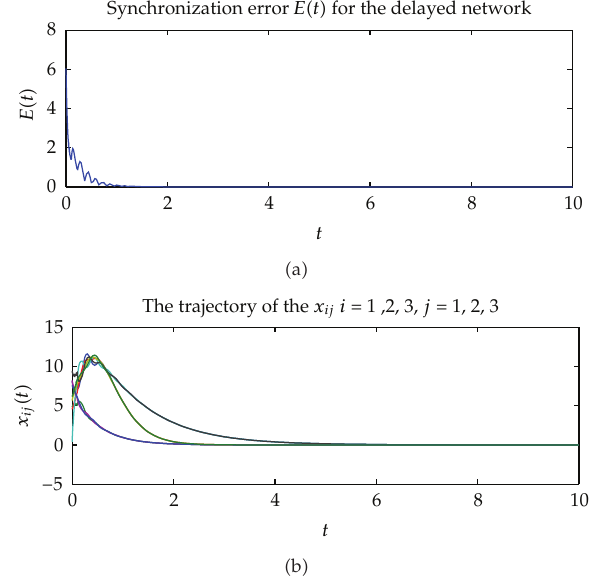
Figure 2: Synchronization evolution E (cid:3) t (cid:4) for the delay-dependent network with c 1 (cid:8) 0 . 5, c 2 (cid:8) 1, and τ (cid:8) 0 .